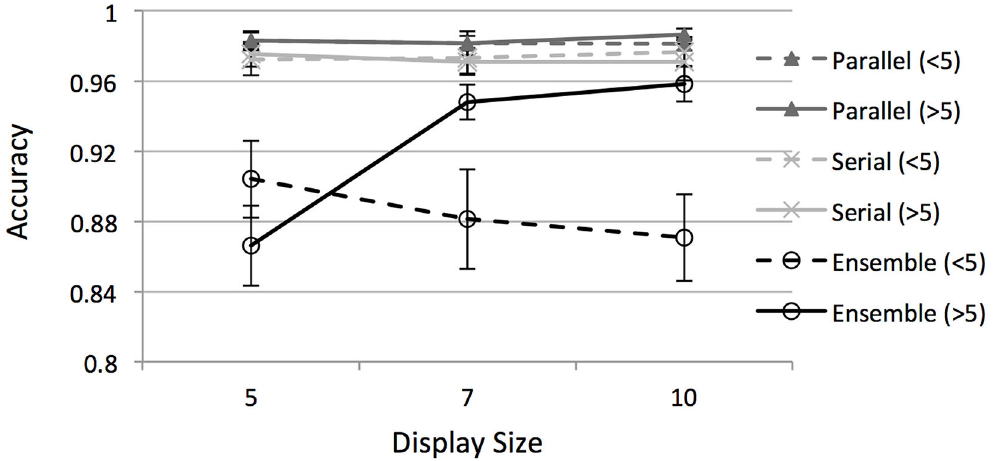
Figure 5. Accuracy for the serial search (light gray), parallel search (dark gray), and ensemble (black) tasks in Experiment 1 plotted as a function of display size and separated by target type (dashed lines indicate < 5 and solid lines indicate > 5). Note. Error bars represent standard error of the mean. The only significant effect of display size on accuracy reflected increased accuracy with larger displays in the greater-than-five condition (black solid line), F (2, 30) = 19.77, p <